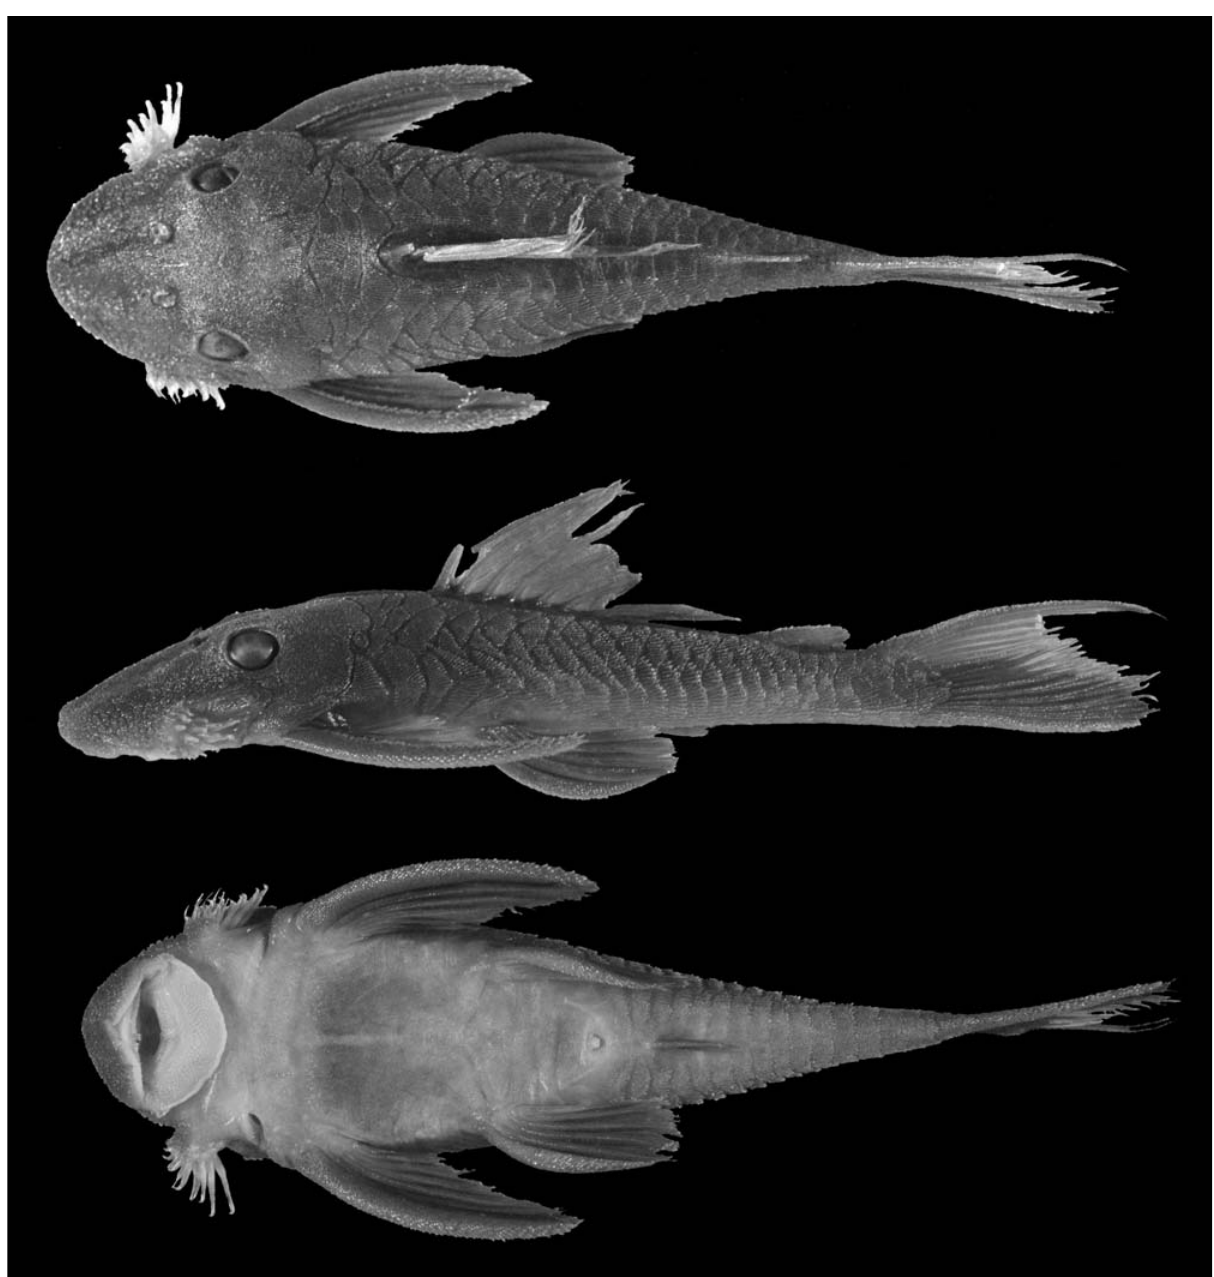
Fig. 8. Dorsal, lateral, and ventral views of Lasiancistrus schomburgkii , FMNH 111717, 124.0 mm